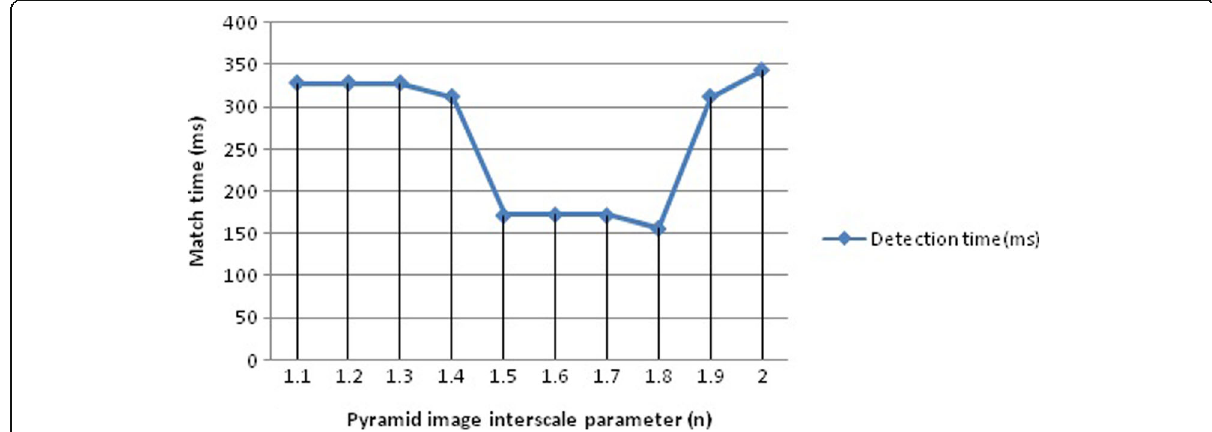
Fig. 19 Time-dependent relationship between scale parameter variation and matching between pyramid images